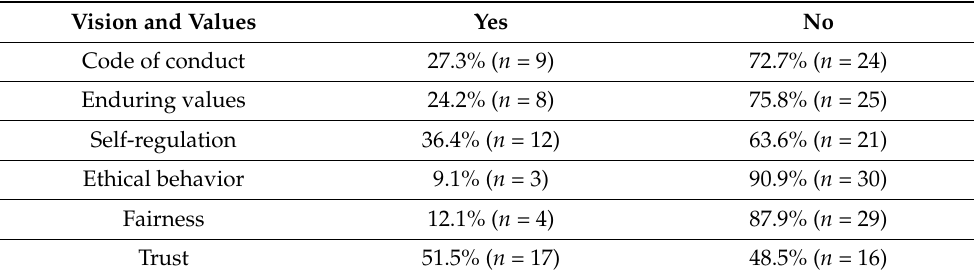
Table 8. Aspects of CSR activities: vision and values.